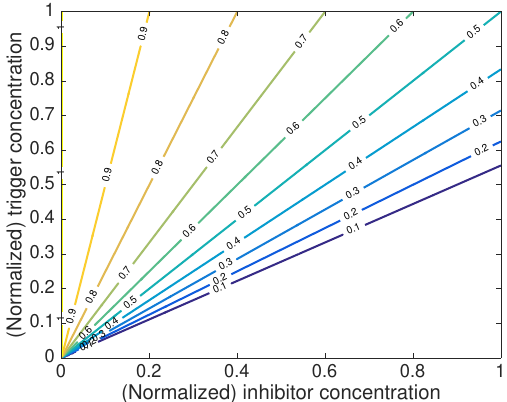
Figure 7. Contour lines of P ( c i , c t , c p ) / b for the whole range of values of the concentration c i of the inhibitor concentration and c t of the release-triggering